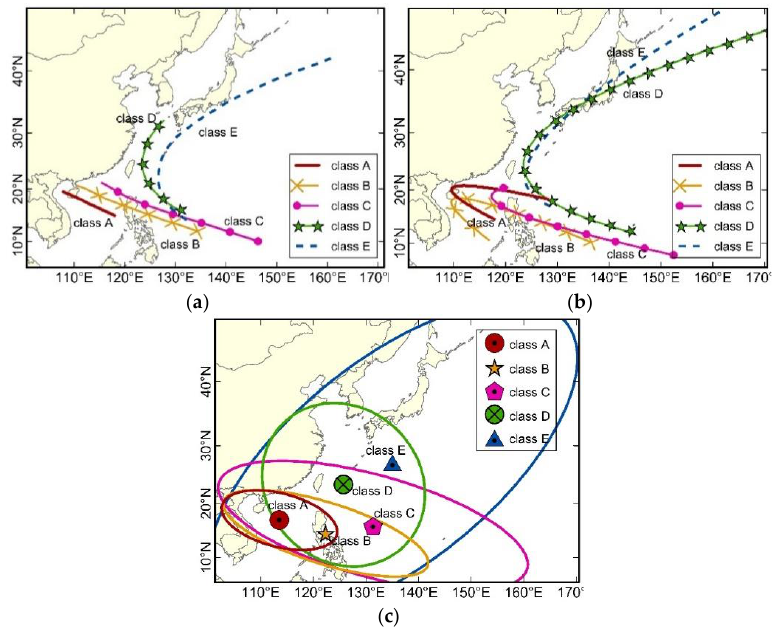
Figure 2. Clustering centres of the tropical cyclone (TC) trajectory obtained by different clustering algorithms: ( a ) clustering centre for the equal division of the trajectory method, ( b ) clustering centre for the mixed regression model method, and ( c ) clustering centre for the mass moment of the trajectory method. Table 1. Statistics for the length of the tropical cyclone (TC) trajectories in each category.